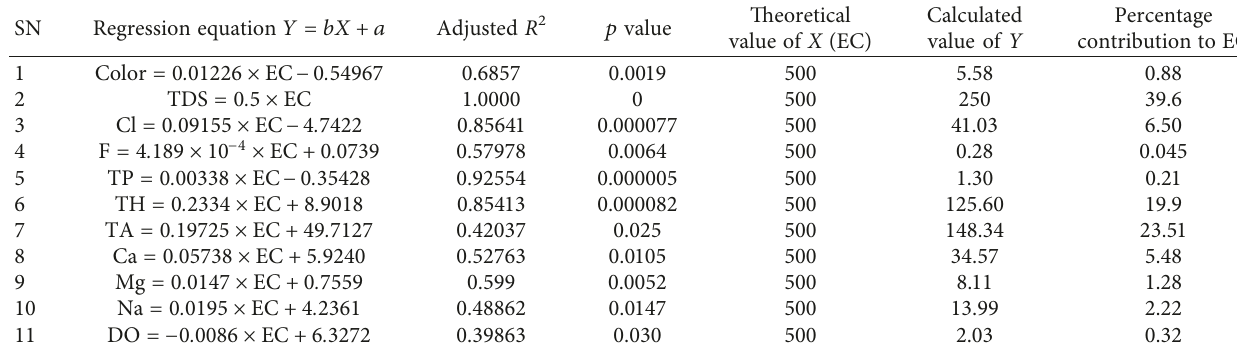
Table 4: Linear regression equations of different physicochemical parameters and EC.